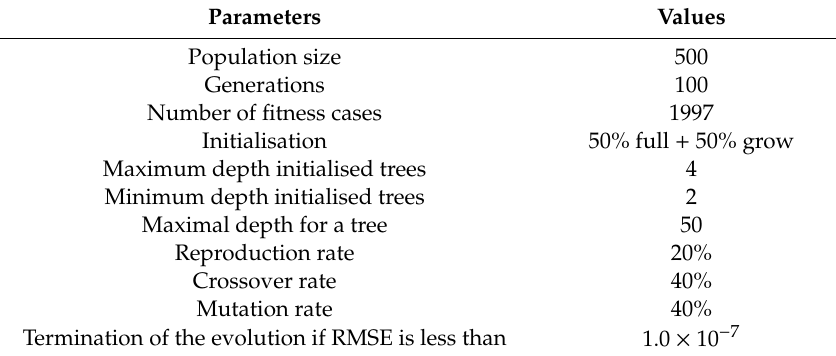
Table 2. Main evolution parameters used in GP metamodel